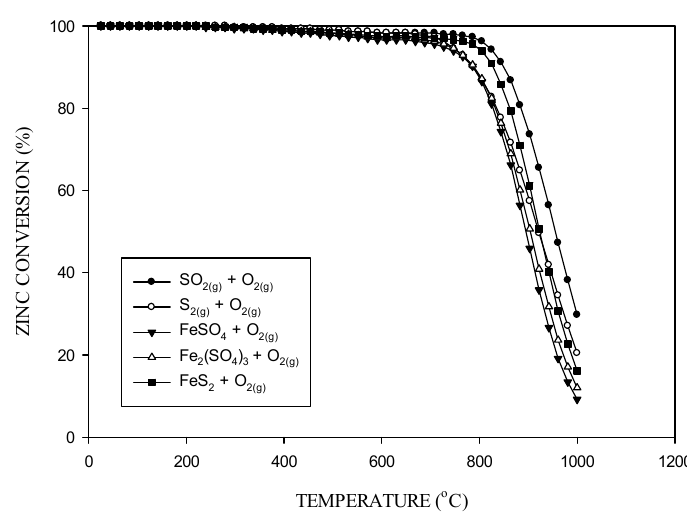
Figure 11 . Percent conversions of zinc oxide to zinc sulphate as a function of temperature for the various alternative reagents. various alternative